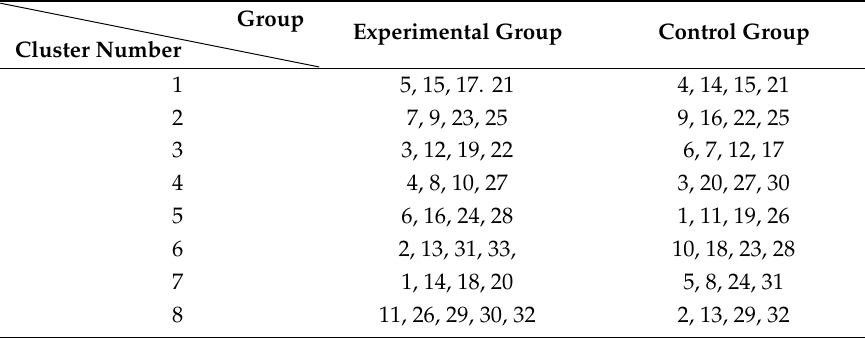
Table 1. The derived interdisciplinary collaborative learning